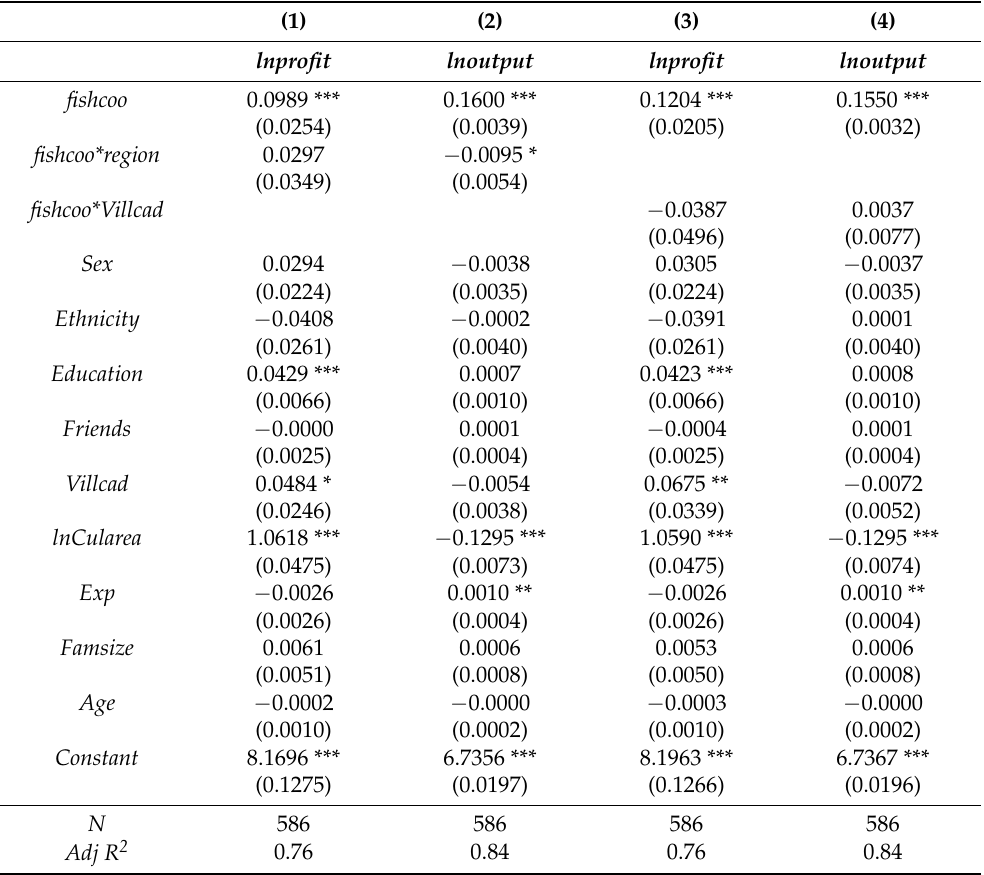
Table 3. Heterogeneity test results based on region and village cadre